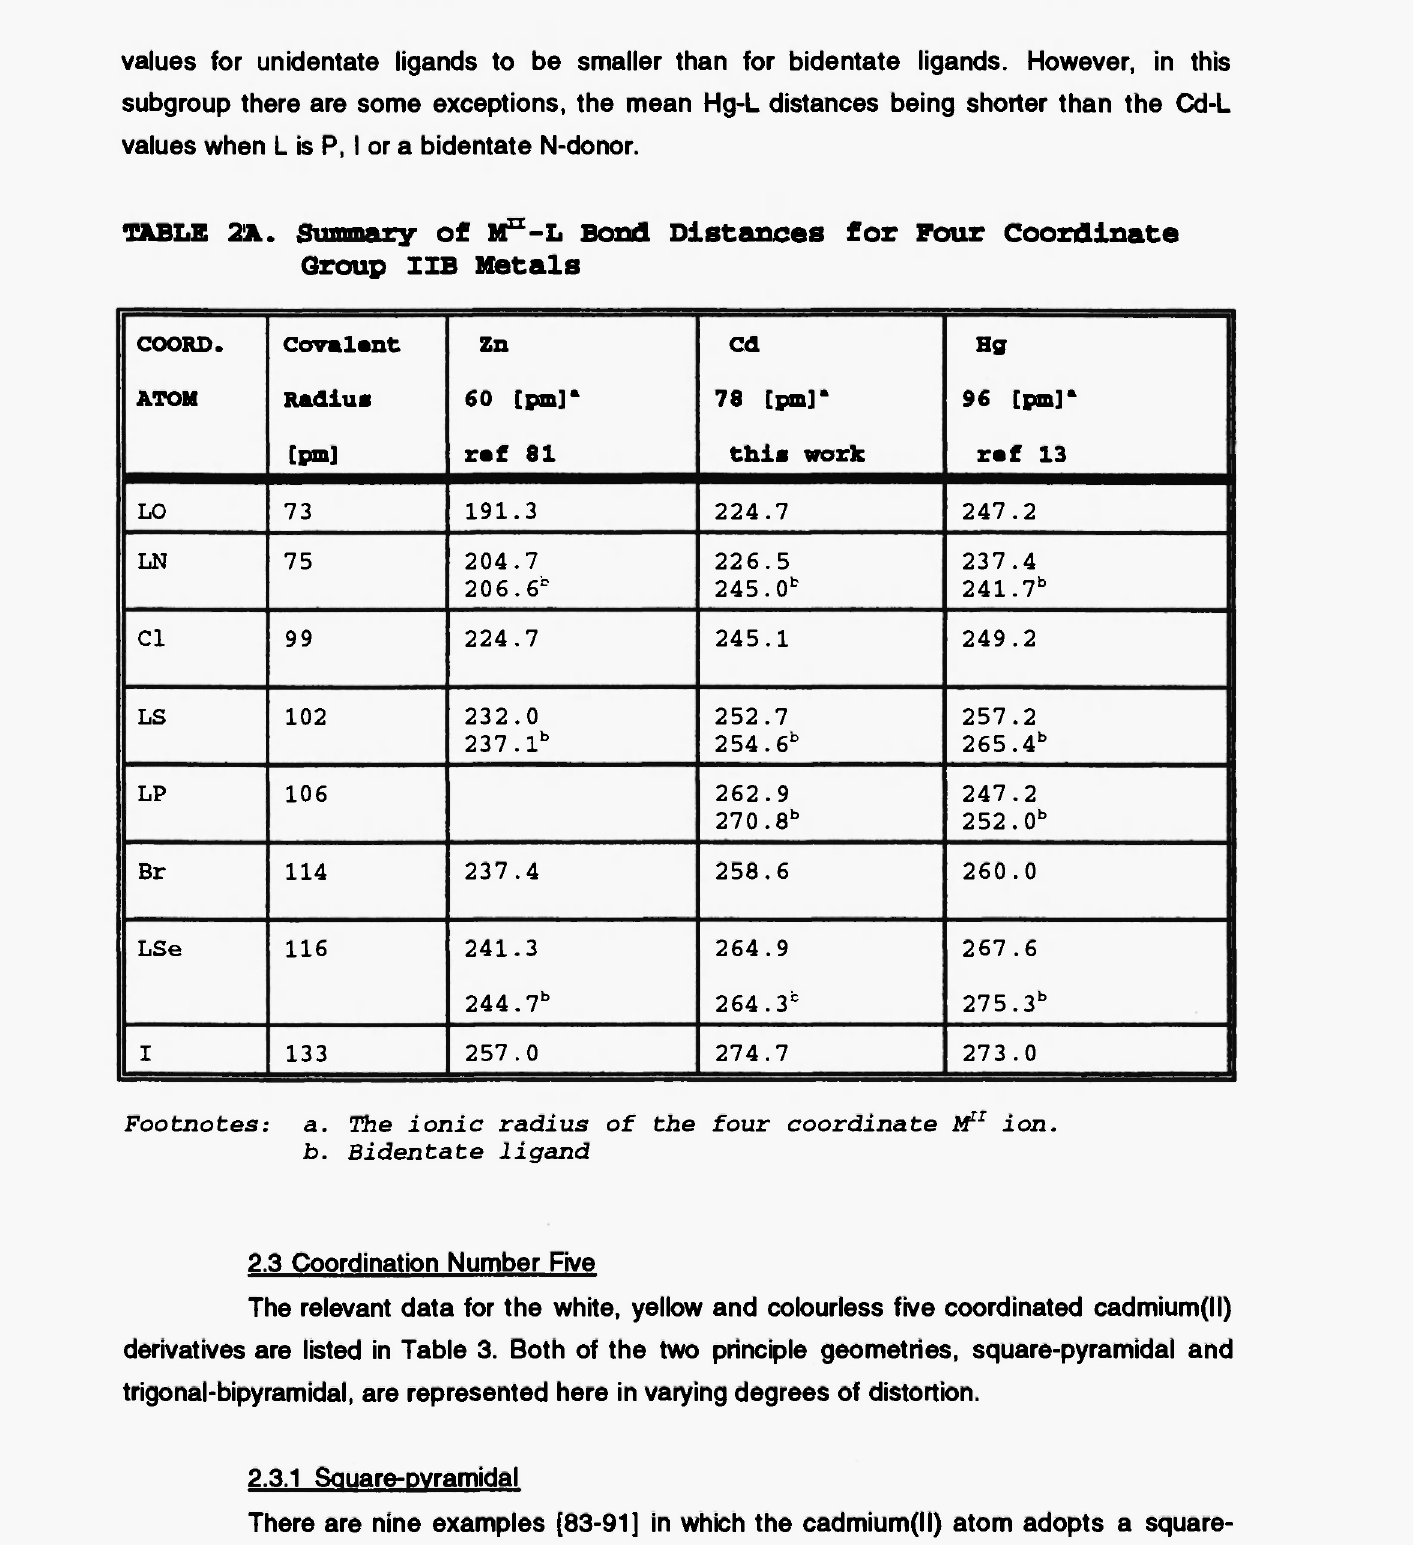
TABLE 2A. Summary of M^-L Bond Distances for Four